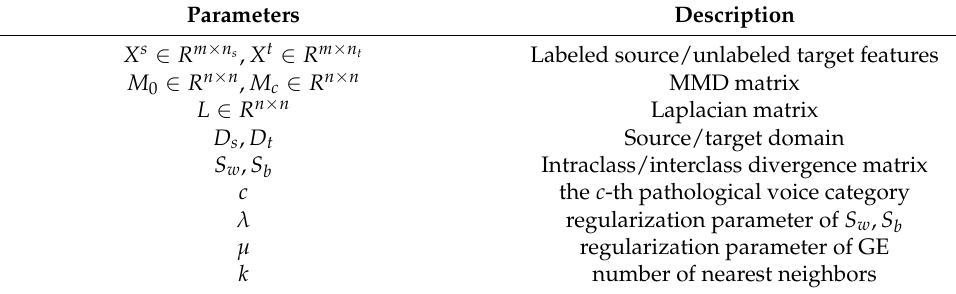
Figure 1. Flowchart of the proposed method. Table 1. Description of frequently used